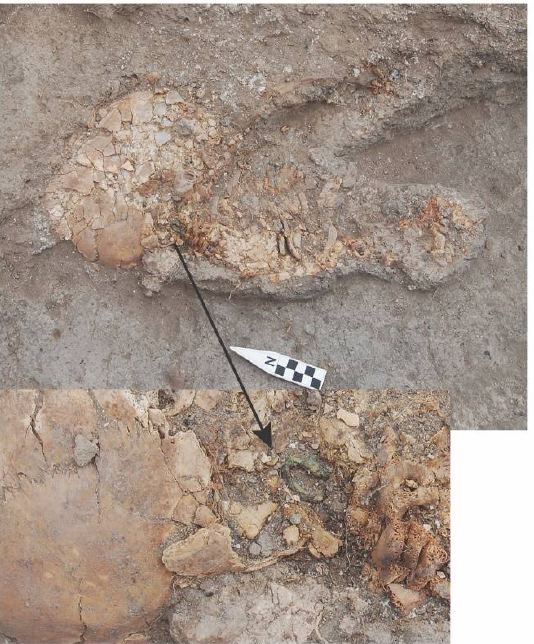
Figure 13. Example of one of the burials (F169) cut into the remodeled area in the southern area courtyard in the Eastern Compound in the Burnt House phase. Top photo shows burial lacking ceramic container, lower photo is a close-up of the copper hair slide (or possibly earring) included in the burial.